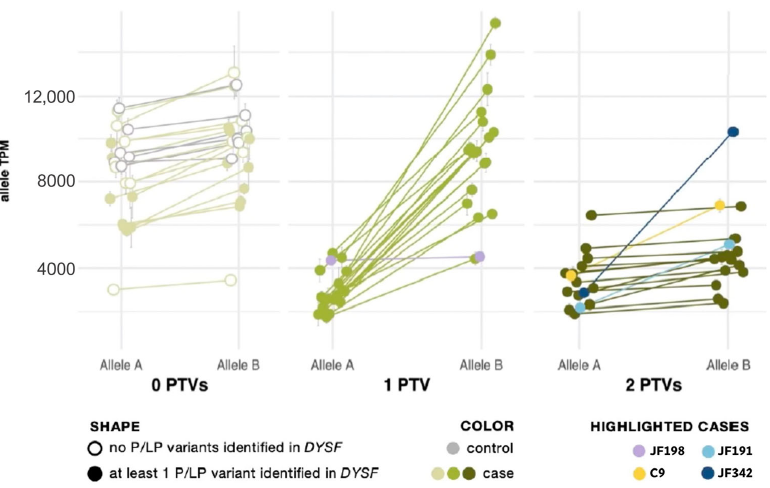
Figure 2. Allele expression imbalance caused by nonsense-mediated decay of transcripts containing a protein truncating variant (PTV). Samples are grouped by the number of PTVs observed in DYSF mRNA. See Supplemental Material and Methods for calculation details. In each sample, the average percent and standard deviation were taken for Allele A and Allele B and mapped onto the sample’s overall gene abundance to estimate the abundance of each DYSF allele copy. Cases with one PTV (medium green dots) show normal expression of Allele B and reduced expression of Allele A (a result of nonsense-mediated decay acting upon the transcript copy containing the PTV). Cases with 2 PTVs (dark green dots) show a reduction in both copies and a ratio of Allele A to Allele B similar to cases with 0 PTVs (light green dots). Highlighted cases (lavender, yellow, teal, navy) are examples of the need to use caution in the interpretation of AEI (see text for